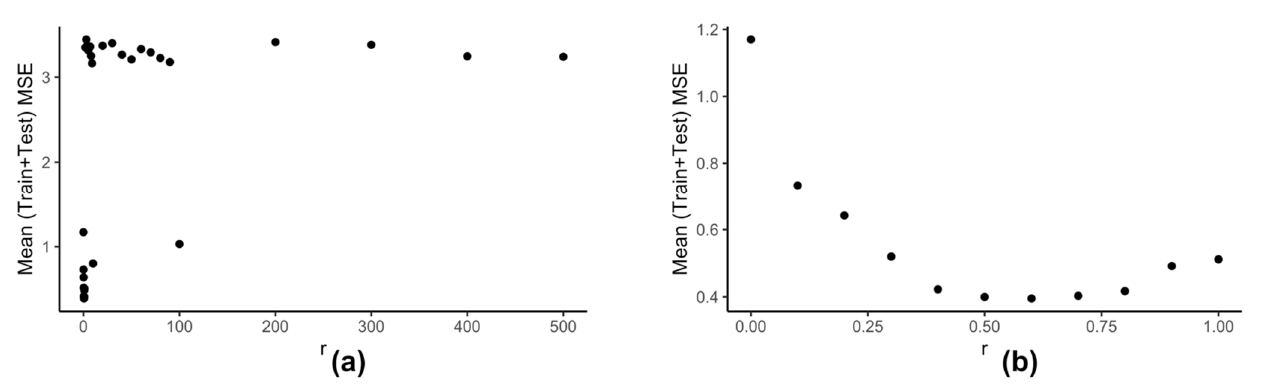
Figure 6. Variation of performance of kESVR with respect to r for drug zebularine. ( a ) r is varied from 0 to 500. ( b ) Shows the details from (a) when r is varied from 0 to